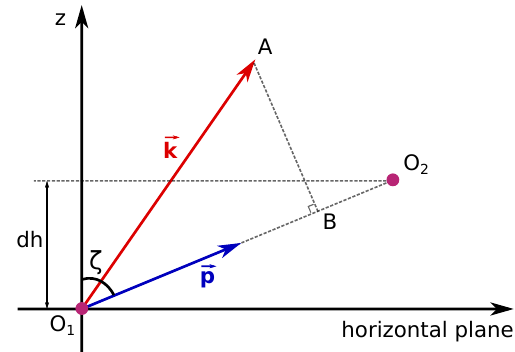
Figure 10. Observation geometry at a tangent point of an altitude profile. Two purple dots ( O 1 and O 2 ) represent two tangent points. The red arrow shows the wave vector, while the blue arrow is the normalized vector of the profile vector O 1 O 2 . d h is the altitude difference between O 1 and O 2